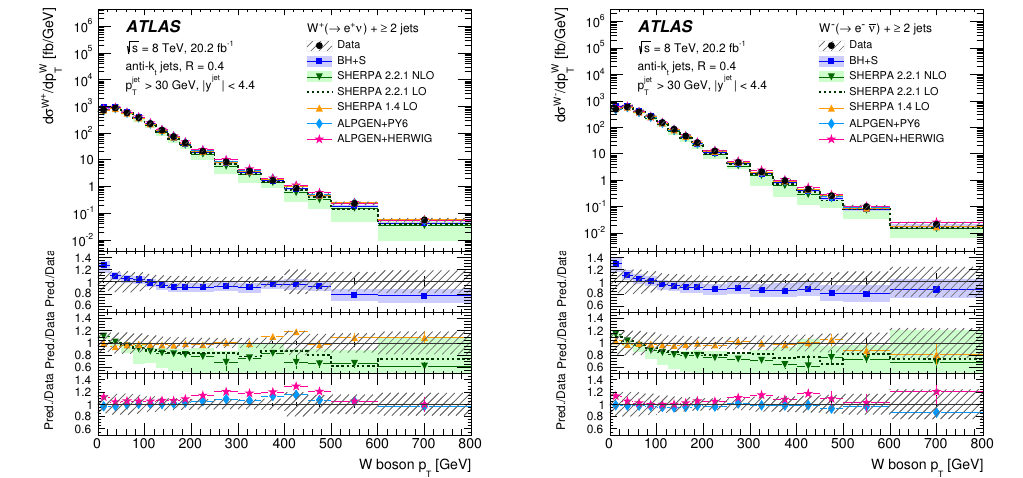
Figure 26 . Di(cid:11)erential cross sections for the production of W + (left) and W (cid:0) (right) as a function of the W p T for events with N jets (cid:21) 2. For the data, the statistical uncertainties are indicated as vertical bars, and the combined statistical and systematic uncertainties are shown by the hatched bands. The uppermost panel in each plot shows the di(cid:11)erential cross sections, while the lower panels show the ratios of the predictions to the data. The theoretical uncertainties on the predictions are described in the text. The arrows on the lower panels indicate points that are outside the displayed range.